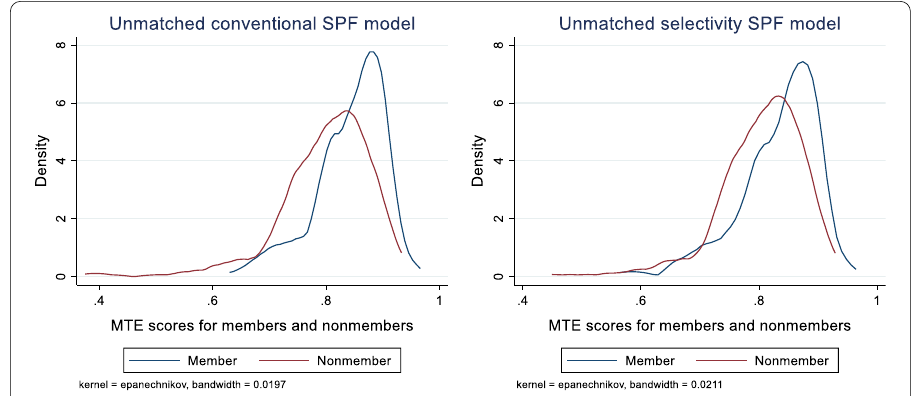
Fig. 4 Metafrontier efficiency scores for members and nonmembers in unmatched SPF models. Source : Authors’ illustration based on survey data